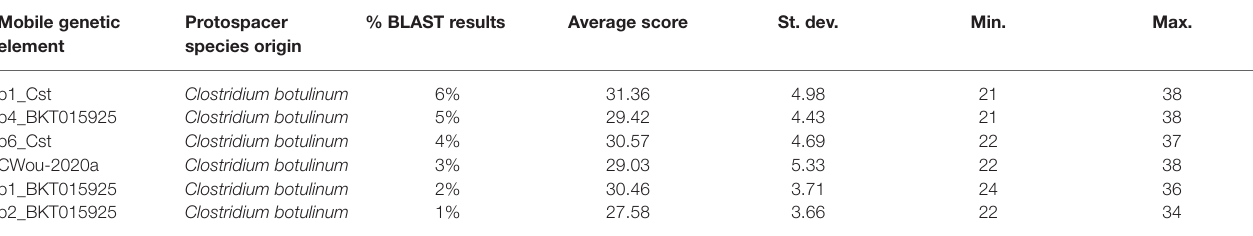
Table 2B: Spacer BLAST scores of the main targeted C. botulinum mobile genetic elements